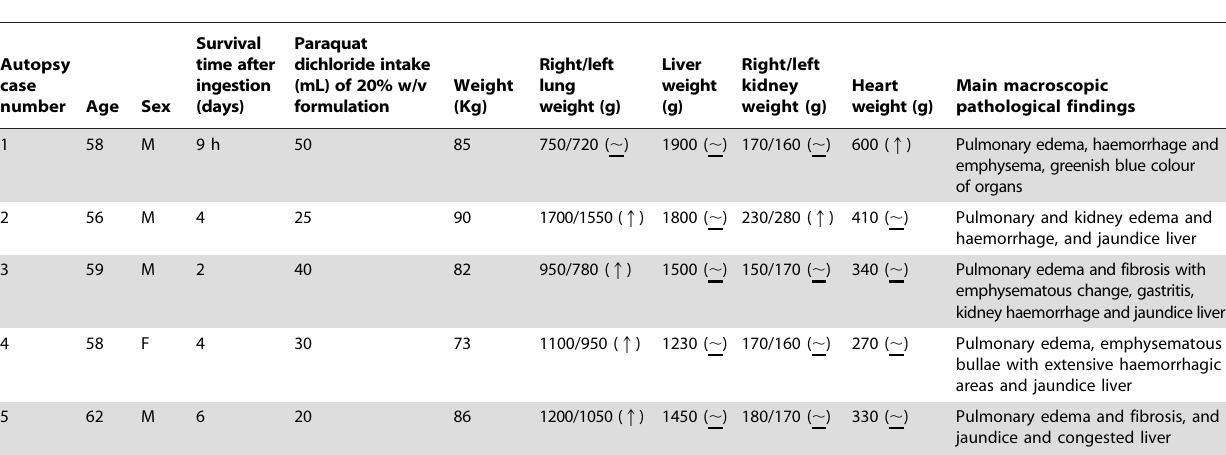
Table 1. Demographic data of fatal victims of paraquat poisonings and relevant clinical, autoptic and pathomorphological findings.